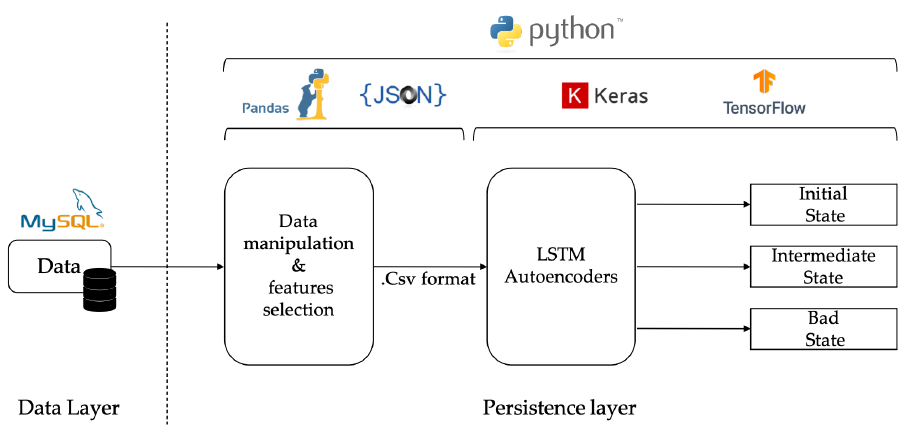
Figure 2. LSTM-autoencoder